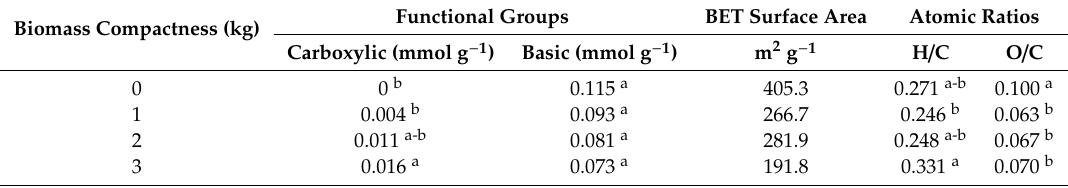
Figure 3. ( A ) pH of biochar from wood chips produced at varying biomass compactness (airflow 20 L/min, moisture content 10%, particle size 7 mm), and ( B ) the correlation between pH and reaction temperature. Di ff erent letters represent significant di ff erence level at 10%. Table 5. Chemical properties of biochar from wood chips produced with varying biomass compactness. BET: Brunauer-Emmett-Teller.